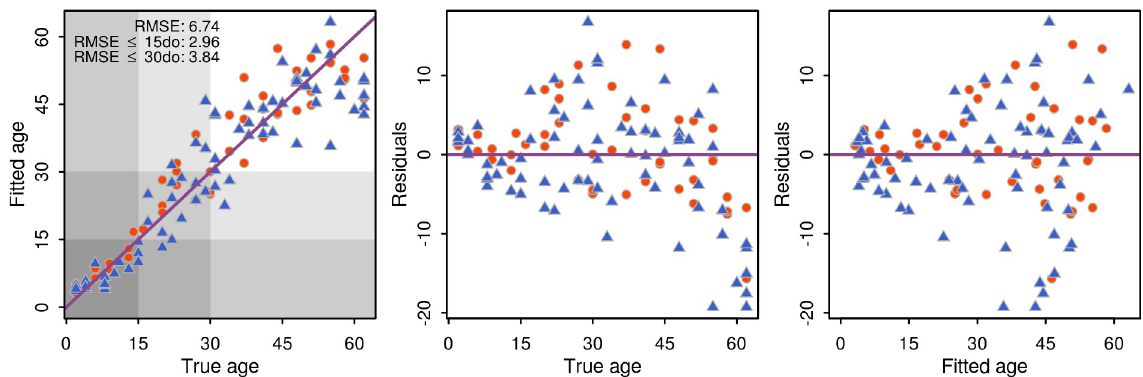
Fig 5. Prediction accuracy of the XGB model was highest (RMSE lowest) for individuals under 15 days old (2.96), and highest when all individuals were considered (6.74). Females are shown as blue triangles and males as orange circles. Purple line shows idealised perfect prediction.